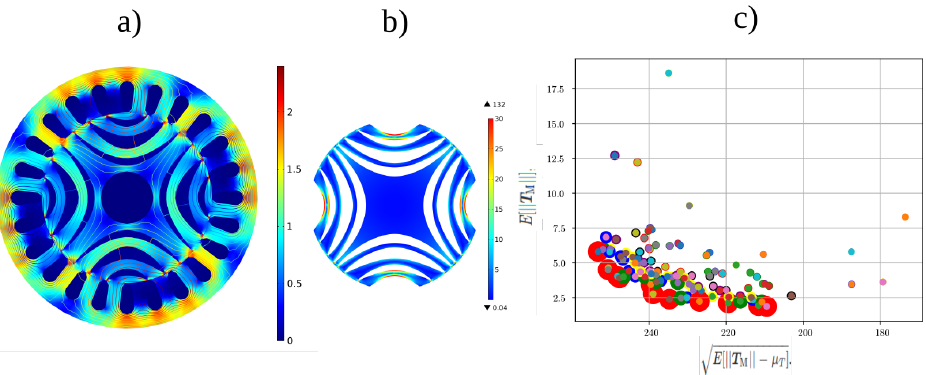
Figure 3. Optimization and multi-physical analysis of a reluctance machine, where ( a ) shows the flux density at the optimal shape of the machine, ( b ) depicts the von Mises stress, and ( c ) plots the distribution of the Pareto-optimal solutions. The y axes represent the average of the calculated torque, while the x axes represent the standard deviation of this torque from the average (torque